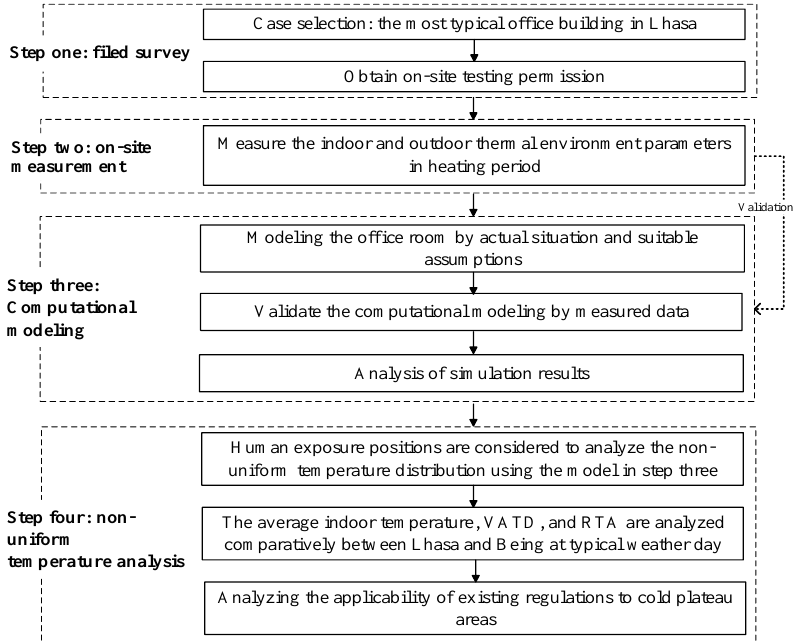
Figure 1. Research flow